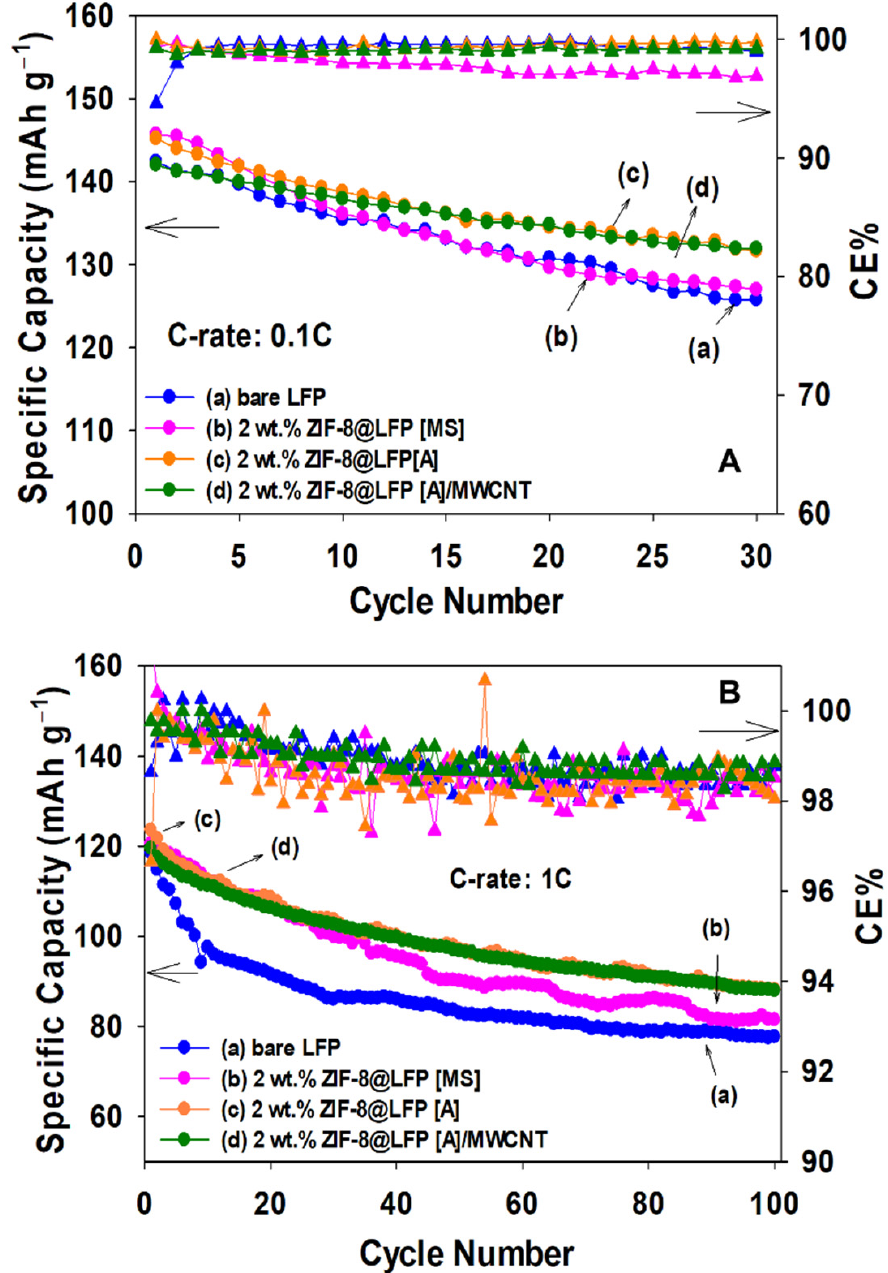
Figure 6. Cycle stability curves of the (a) bare LFP, (b) 2 wt.% ZIF-8@LFP [MS], (c) 2 wt.% ZIF-8@LFP [A] and (d) 2 wt.% ZIF-8@LFP [A]/MWCNT electrodes at 0.1C/0.1C rate for 30 cycles ( A ), and at 1C/1C rate for 100 cycles ( B ).